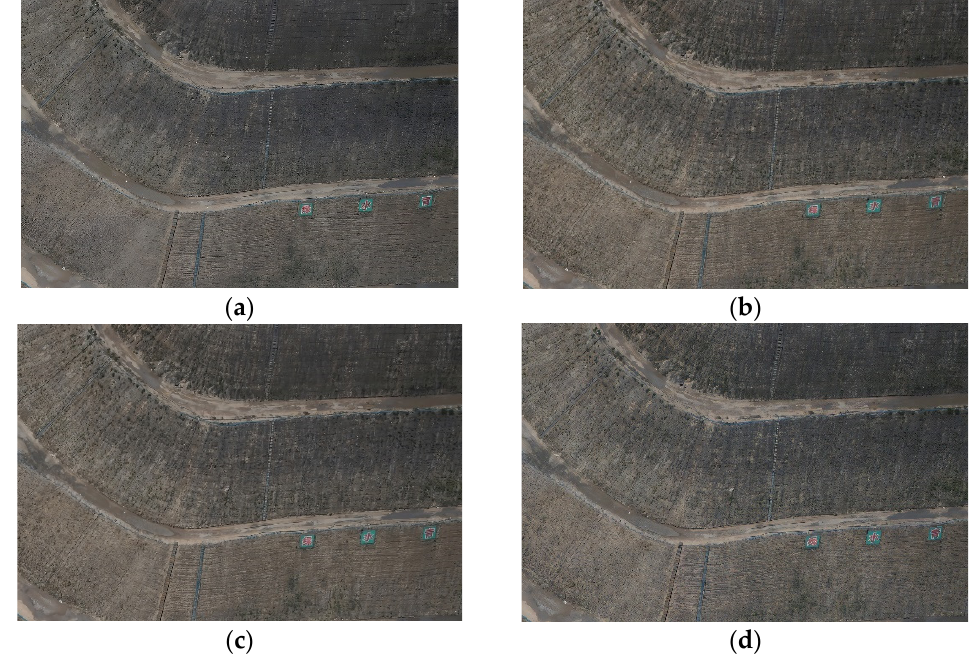
Figure 8. Comparison of results for green areas ( a ) ESRGAN, ( b ) Real-SR, ( c ) SRMD, ( d ) WAIFU2X.